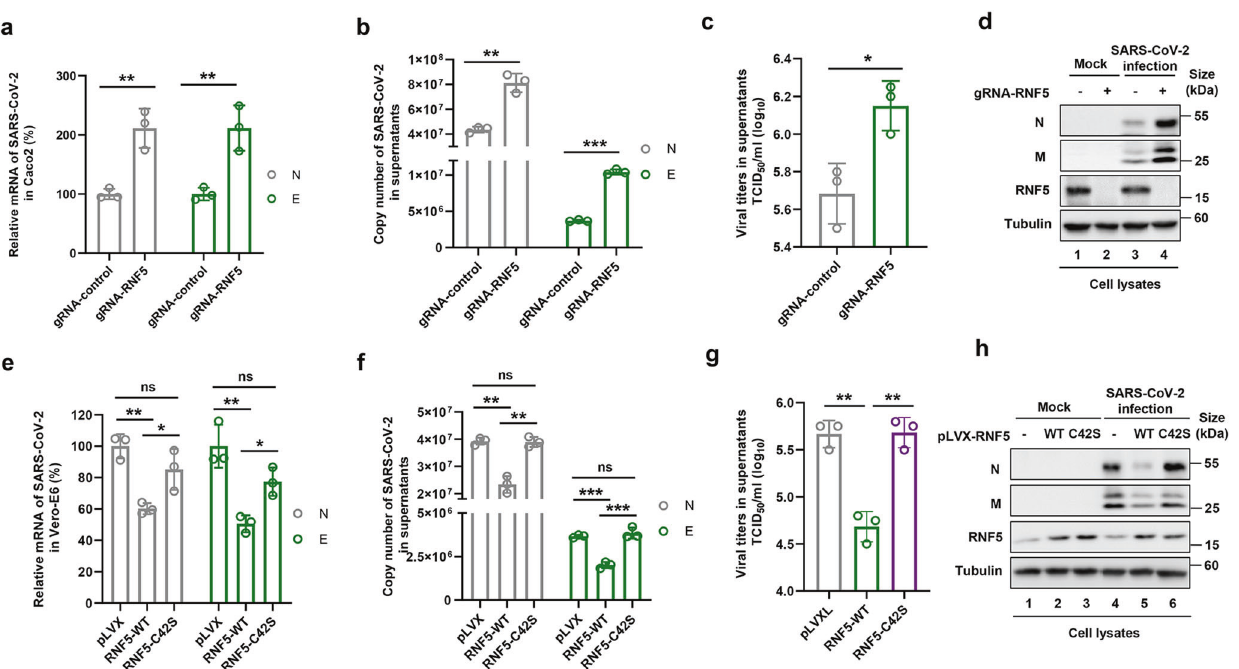
Fig. 4 RNF5 inhibits SARS-CoV-2 replication by targeting the E protein for degradation. a – d RNF5 knockout in Caco2 cells increased viral replication measured by determining mRNA levels of the N and E genes in cells a and in culture supernatants b , and viral titers in culture supernatants c , and the levels of N and M proteins d . Caco2 cells infected with SARS-CoV-2 for 48 h were used to determine viral replication by RT-qPCR or IB analysis. e – h Overexpression of RNF5 but not the RNF5 C42S mutant in Vero-E6 cells reduced viral replication. Vero-E6 cells overexpressing RNF5 WT or the RNF5 C42S mutant were infected with SARS-CoV-2 for 48 h, and viral replication in cells was determined by RT- qPCR e , and in culture supernatants f , viral titers g or IB analysis h . Statistical signi fi cance was analyzed using two-sided unpaired t-tests (NS, no signi fi cant, * p < 0.05, ** p < 0.01, *** p <